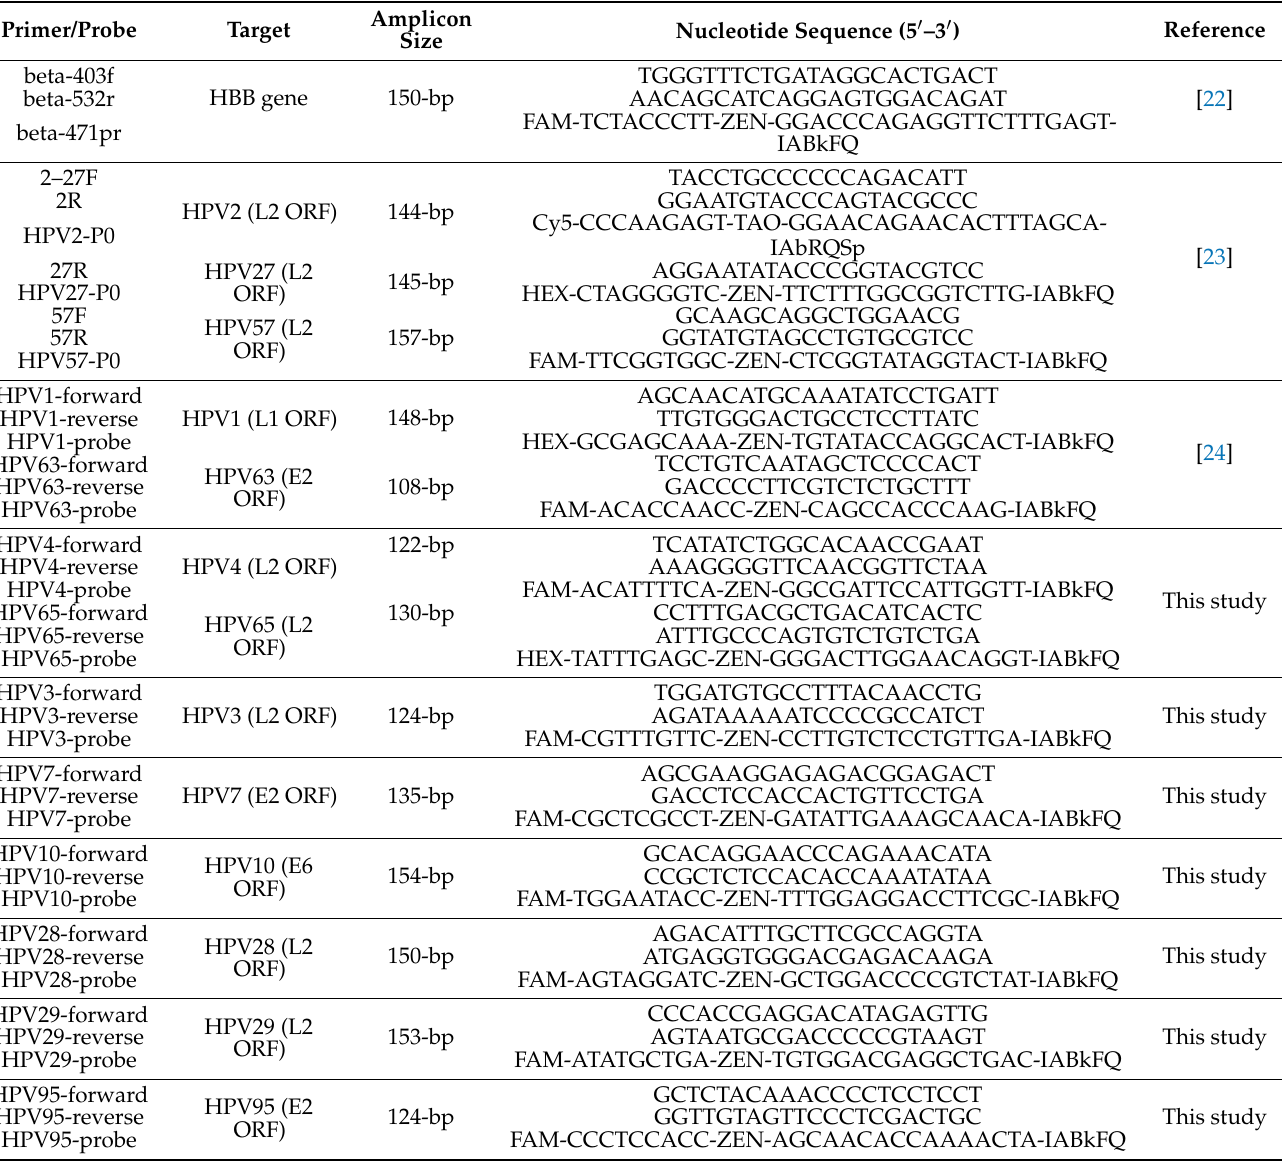
Table 1. Primers and double-quenched probes used in quantitative real-time PCR